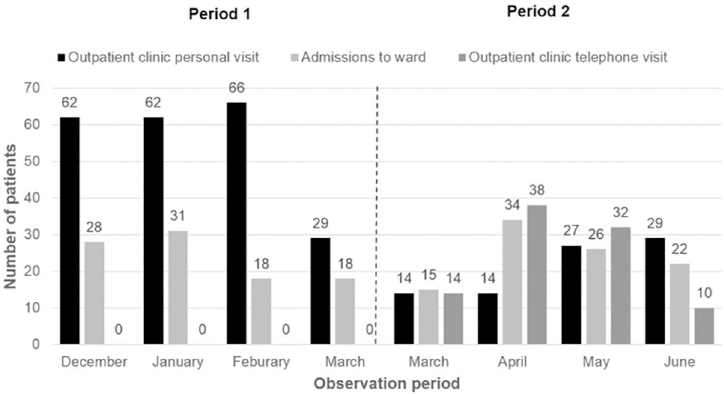
Fig 3. In- and outpatient frequencies at the department of Gastroenterology and Hepatology, including personal and telephone visits at the outpatient clinic and elective and non-elective admissions of patients with HCC to the